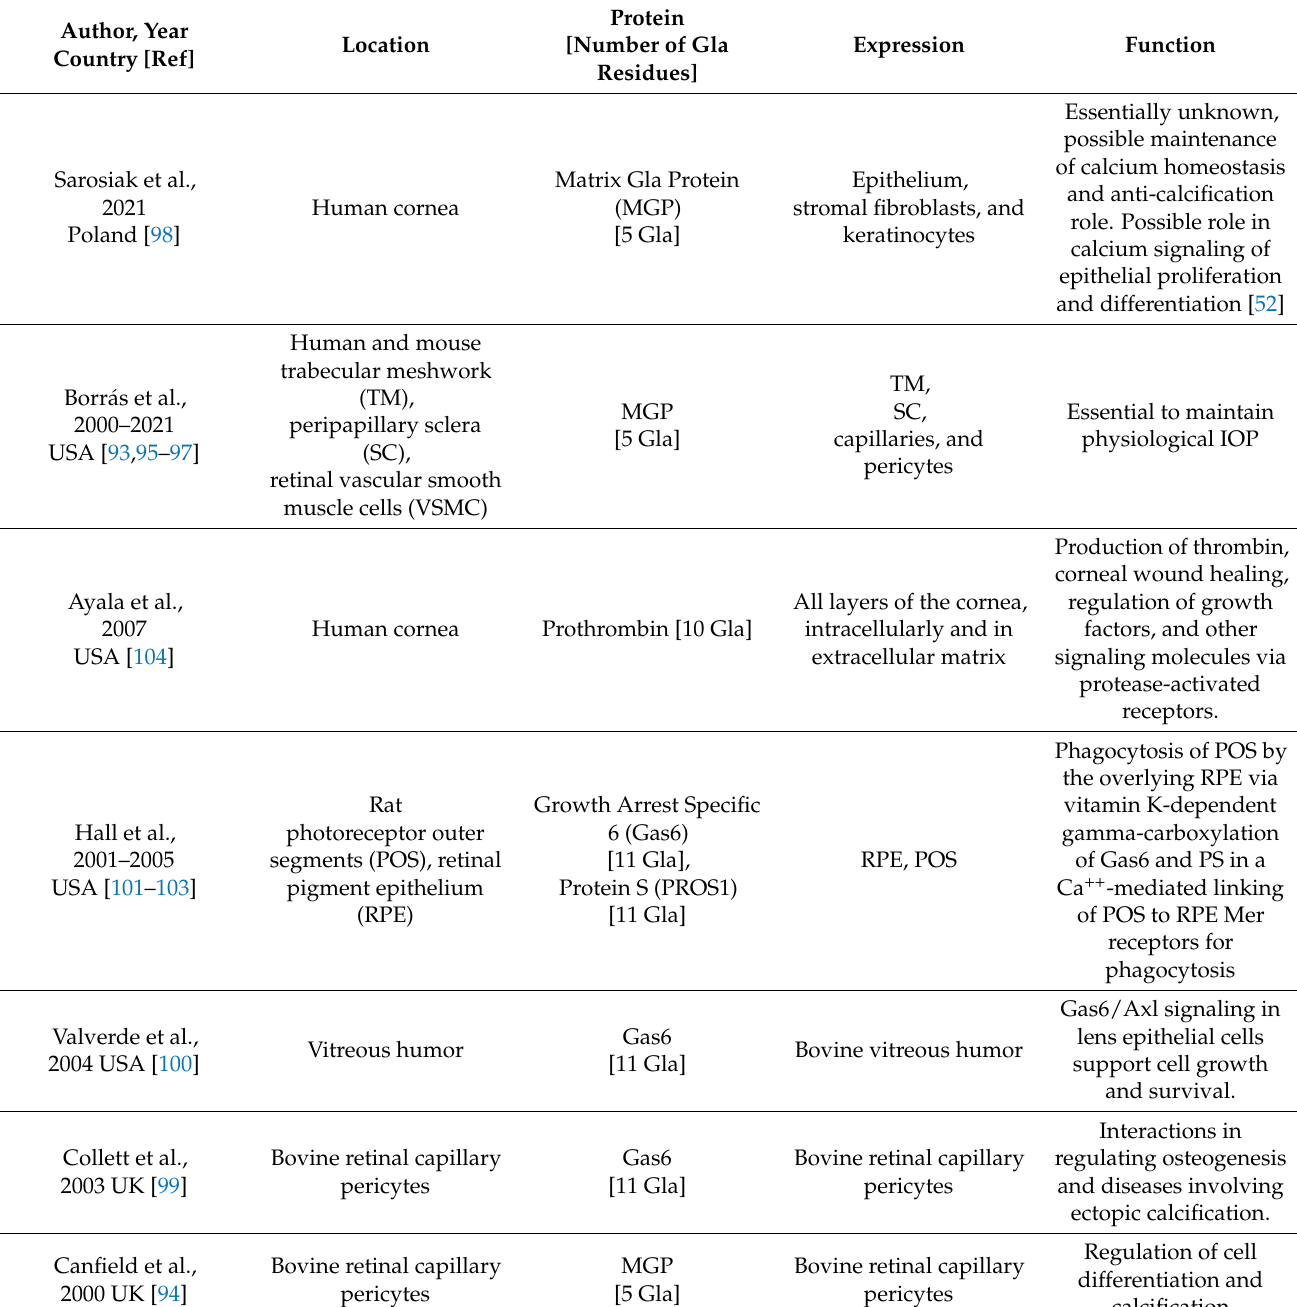
Table 3. Summary of ocular-related VKDP and their